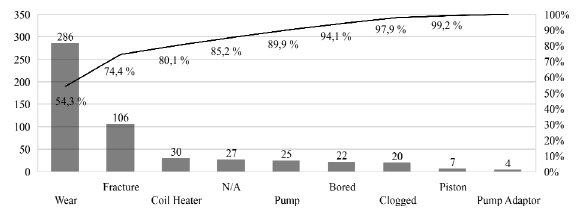
Figure 1. Pareto’s analysis for ZIN failure mode count for the period under study.